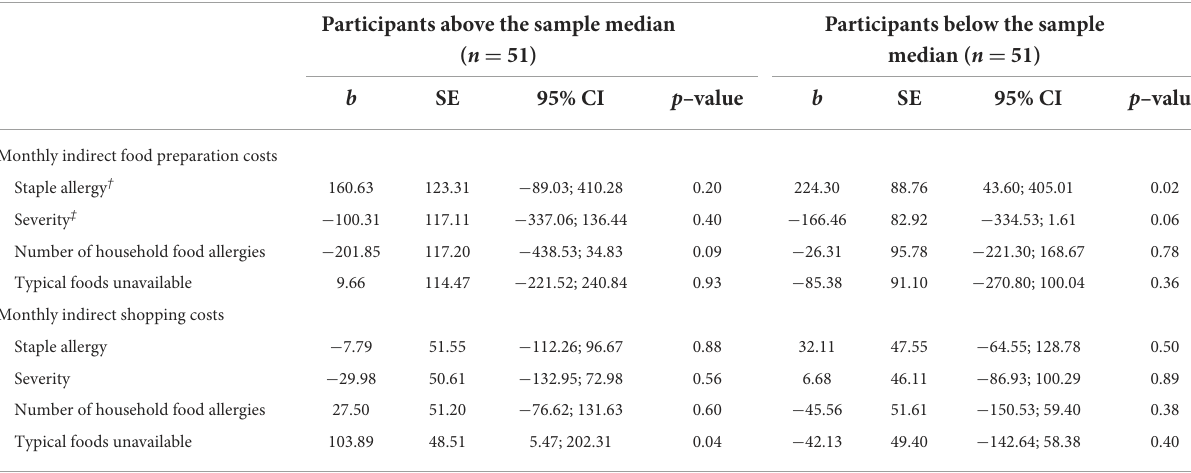
TABLE 3 Predictors of monthly indirect food preparation and shopping costs among higher and lower income households with food allergy. Participants above the sample median Participants below the